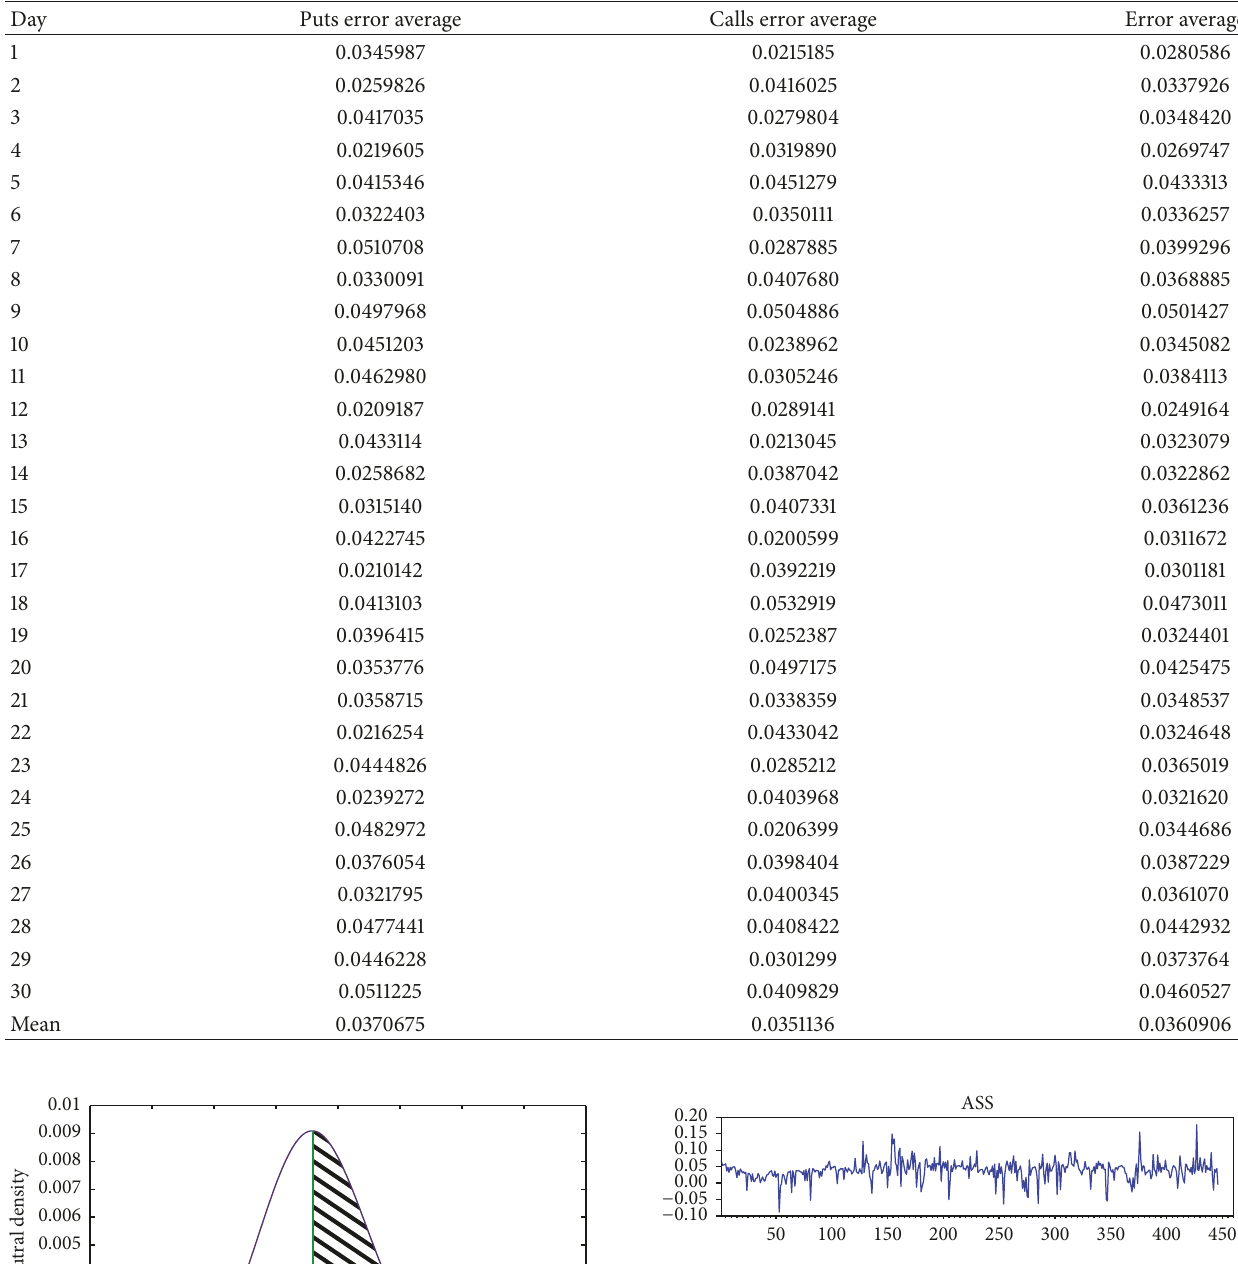
Table 2: The table puts and calls estimation error average.